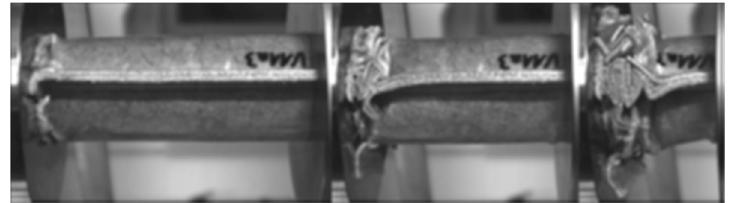
Figure 17. Failure mechanisms for V11 material in a quasi-static test.